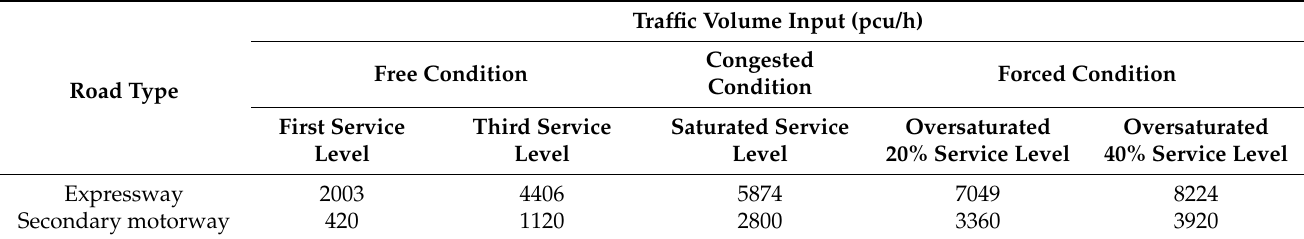
Table 5. Traffic volume on the expressway and the secondary